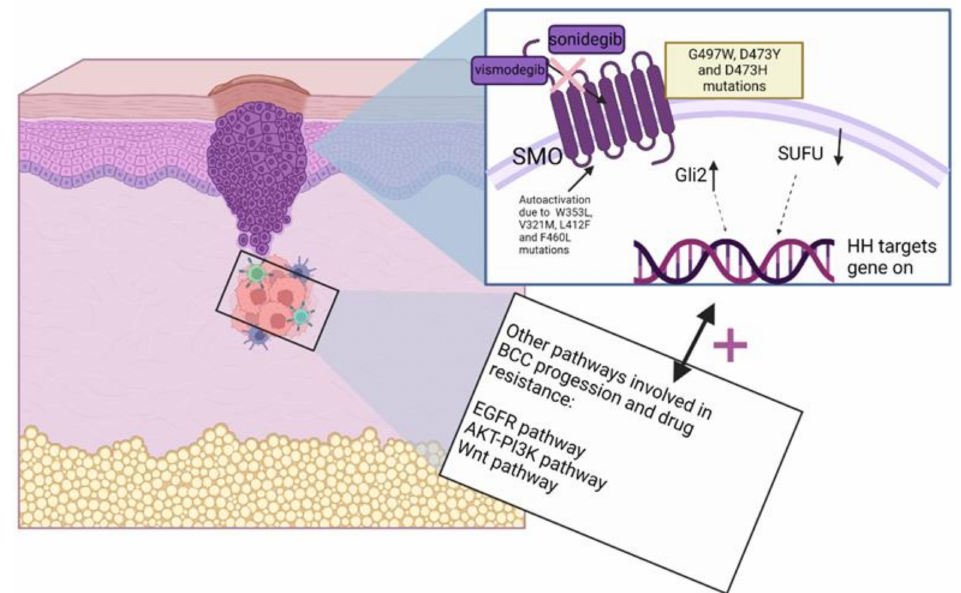
Figure 2. The most common resistance mechanisms in Hedgehog inhibitors treatment involving canonical and non-canonical ways of activating the Hh